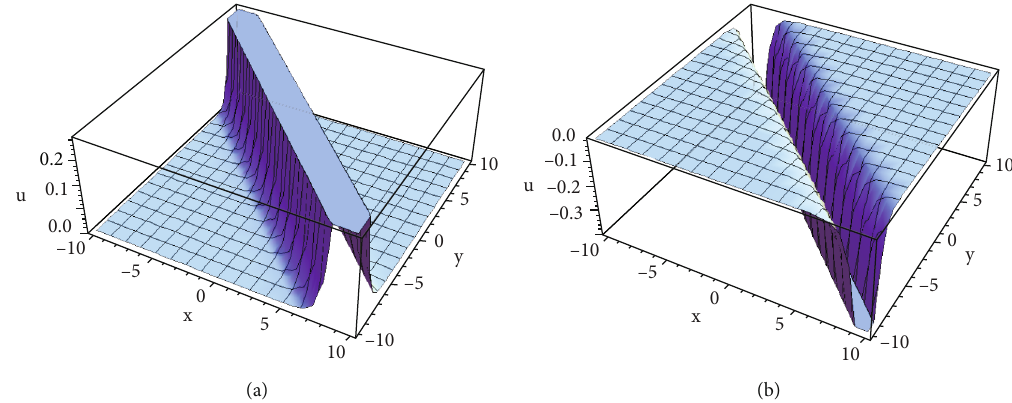
Figure 3: The outline of the kinky-bright soliton. (a) for Eq. (31) and (b) for Eq.